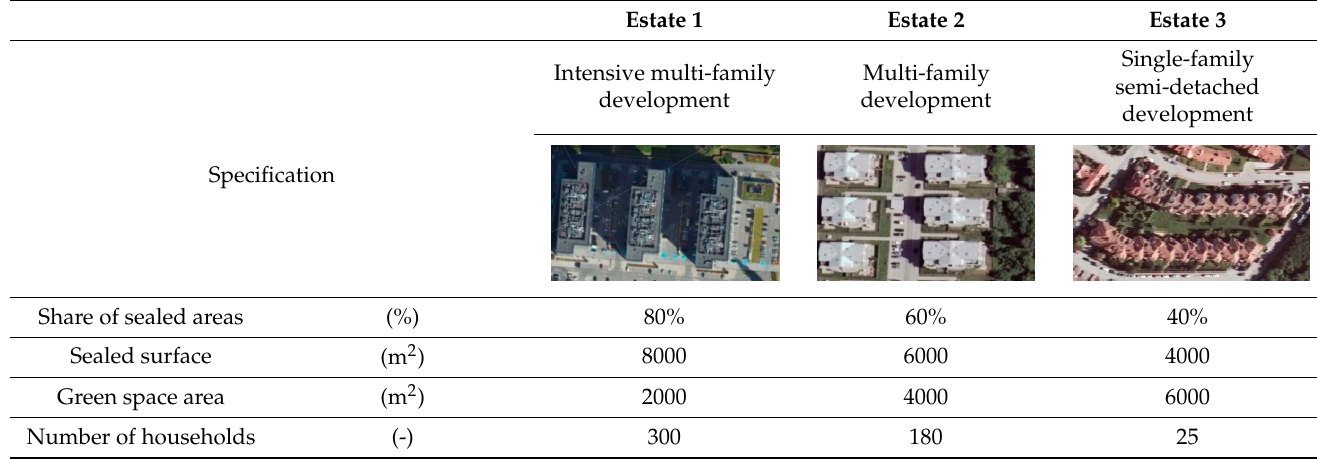
Table 6. Assumed example: three estates typical of urban development.